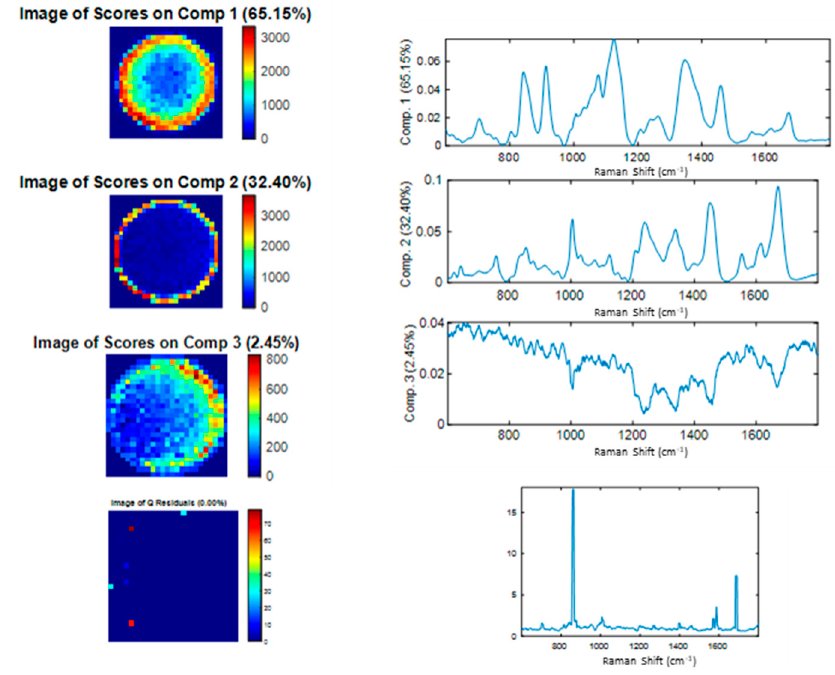
Figure 7. MCR-ALS analysis of trastuzumab at initial product concentration, illustrating the three pure components extracted from the MCR-ALS, after application of SVD, as well as the image of the scores, which are displayed in color code, according to the intensity of the information, from the less intense (blue color) to the more intense (red color).